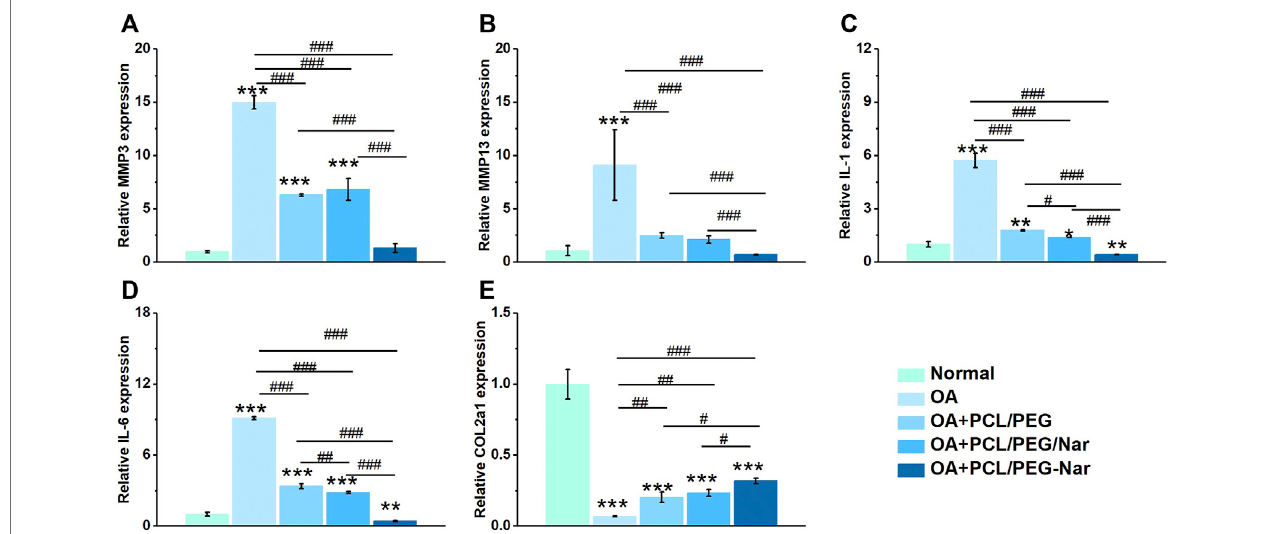
FIGURE 5 | Gene expressions of (A) MMP3, (B) MMP13, (C) IL-1, (D) IL-6, and (E) COL2a1 of chondrocytes on PCL/PEG-Nar nano fi bers after treatment with IL- 1 β .*indicates p < 0.05,**indicates p < 0.01,and***indicates p < 0.001comparedwiththenormalgroup; # indicates p < 0.05, ## indicates p < 0.01,and ### indicates p < 0.001 with comparison between